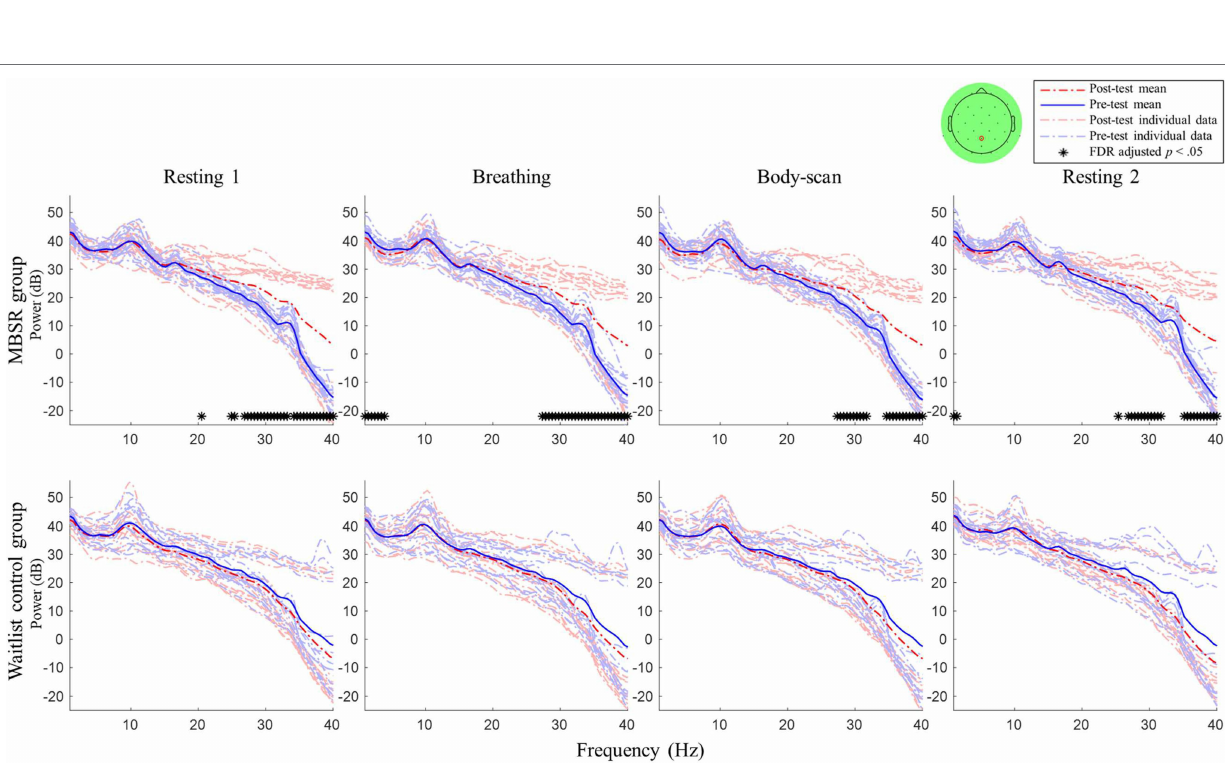
FIGURE 3 | Post–pre-test PSD t- test for channel Pz between the MBSR group and waitlist control. MBSR group n = 17, waitlist control group n =